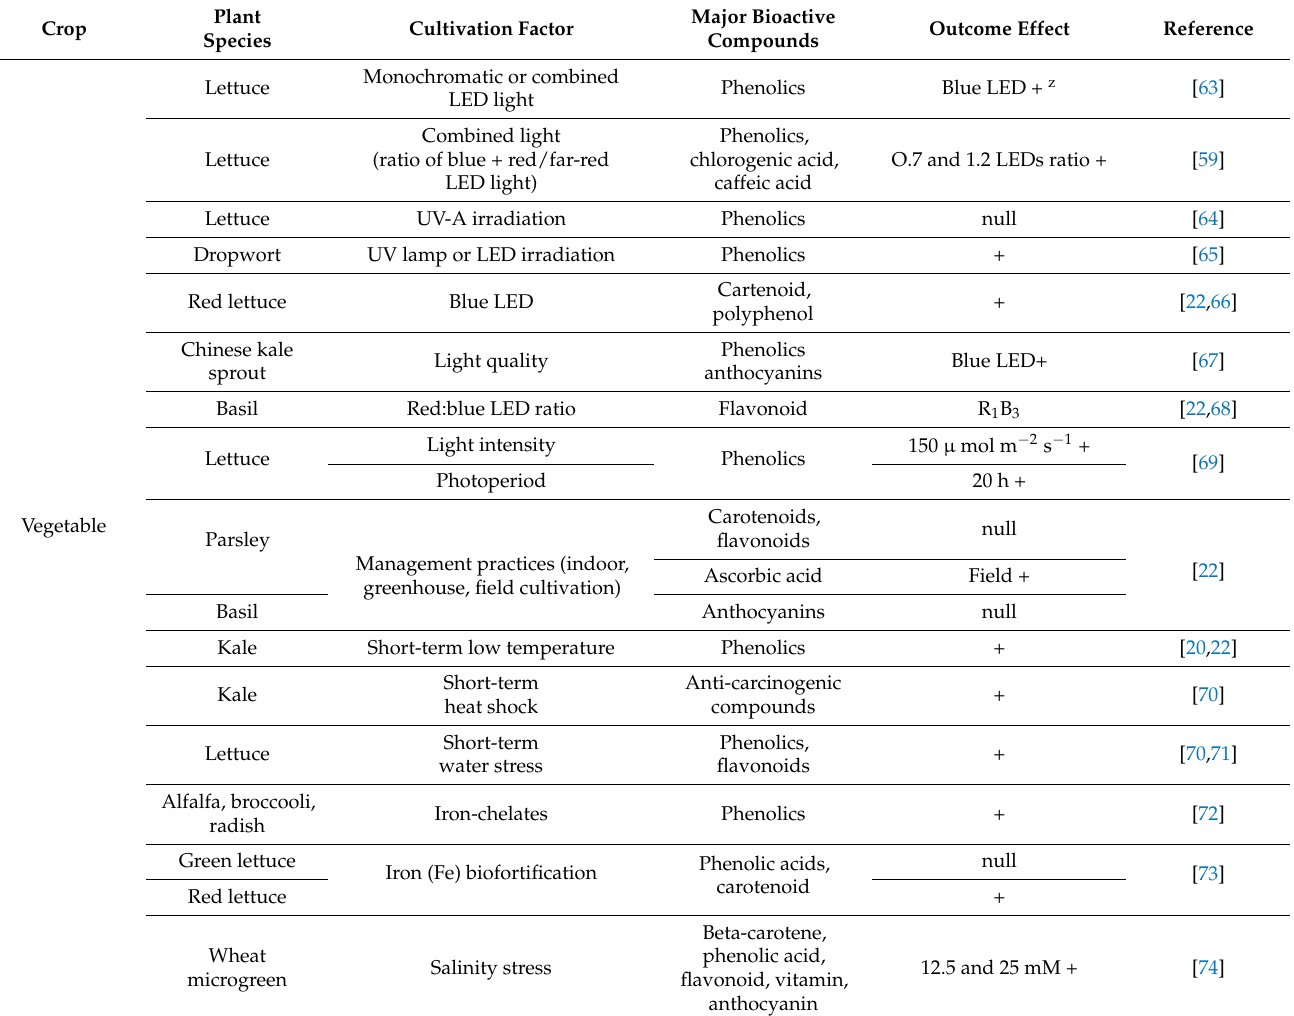
Table 4. Research studies to improve bioactive compound levels in plant foods in building-integrated, controlled urban